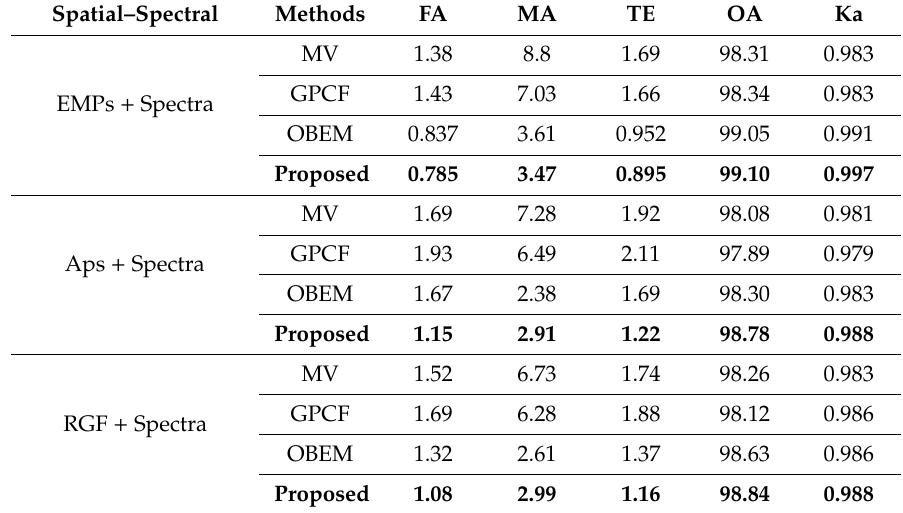
Table 8. Quantitative comparisons (%) between the proposed approach and three post-processing methods with di ff erent spatial-spectral feature fusion strategies in the Site B landslide aerial images.